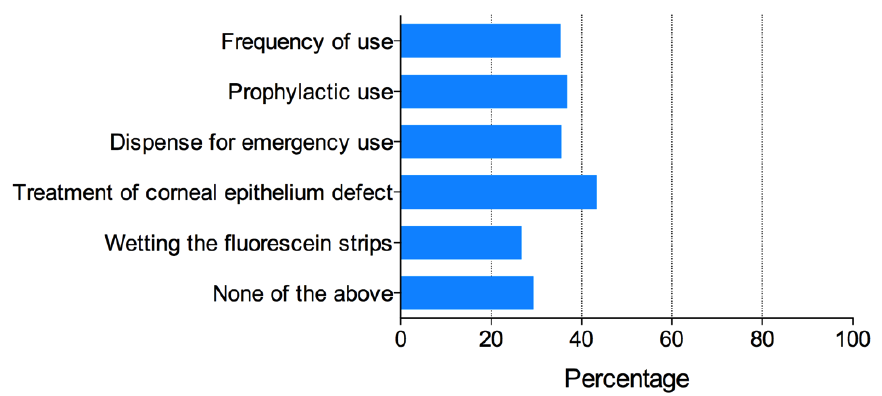
Figure 2. Which aspects of your practice did the article and guidelines change, with respect to the use of antibiotic eye drops in orthokeratology therapy?